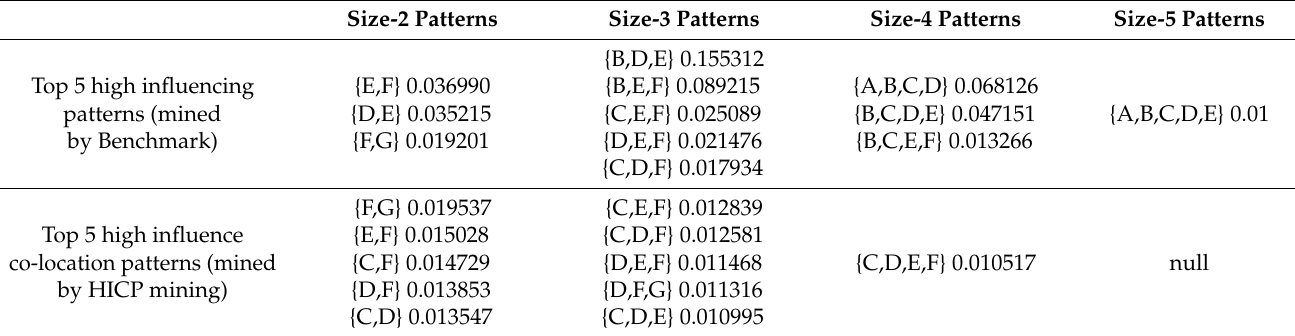
Table 2. Top 5 patterns of high IP and HICP (marked with influence index